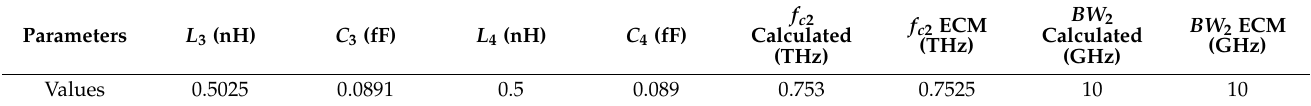
Table 5. List of parameters for second resonance frequency f c 2